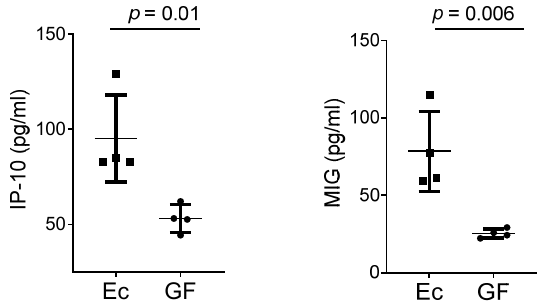
Figure 4. Serum chemokine levels differ between Ec and GF mice. Results are shown for IP-10 and MIG concentrations in sera of Ec and GF mice from one of two independent experiments. p values are shown from unpaired t -test. Results in a repeat experiment trended similarly. When data from the two experiments were combined, unpaired t -test with a Welch correction and Holm–Sidak adjustment for multiple comparisons revealed a significant difference for IP-10 ( p = 0.042).